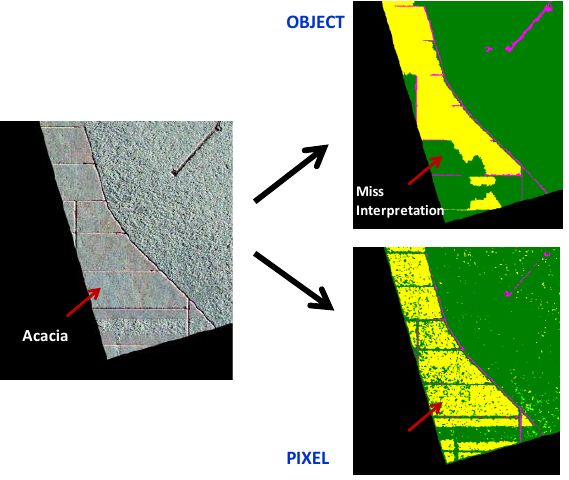
Figure 9. Misinterpretations in object-based classification result